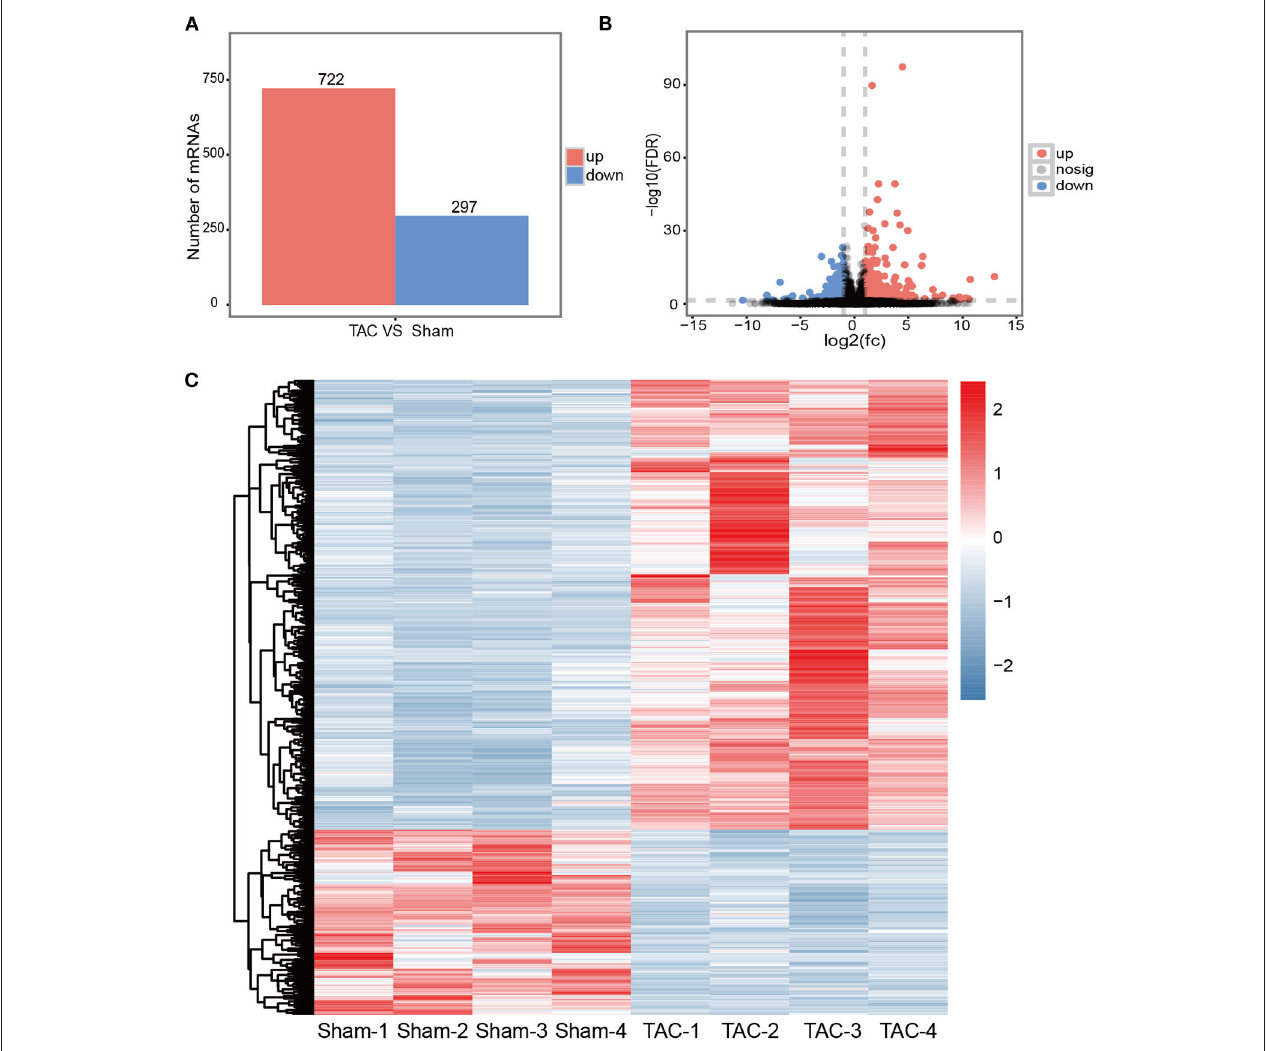
FIGURE 2 | Transcriptional changes in TAC models. (A) An overview of DEGs in TAC models; (B) Volcano plot illustrating DEGs between the TAC and sham groups. Up-regulated mRNAs are labeled in red, down-regulated in blue, and the rest in gray; (C) Hierarchically clustered heat map illustrating DEGs between TAC and sham groups, fold change > 2.0, P < 0.05 and FDR < 0.05, n = 4 per